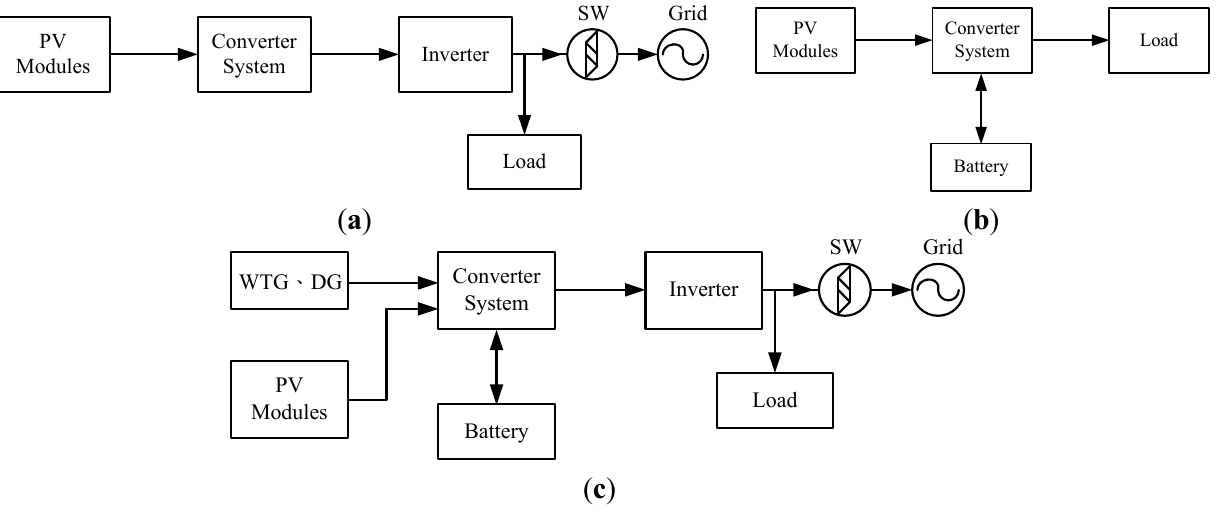
Figure 1. Classification of small generation systems with renewable energy: ( a ) grid-connection system; ( b ) stand-alone system; and ( c ) hybrid system. PV: photovoltaic; WTG: wind turbine generator; DG: distributed generation; and SW: